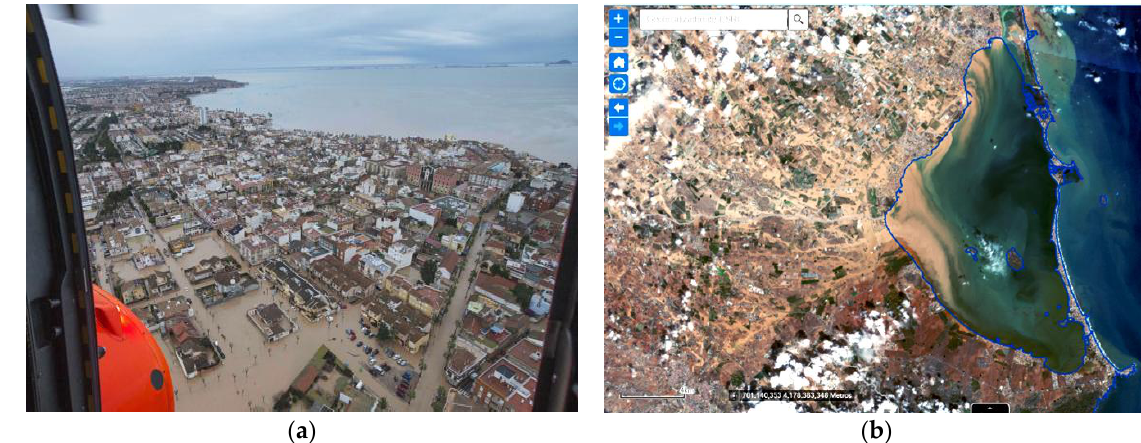
Figure 5 . ( a ) Flooding of the coastal town of Los Alcazares after the DANA ( depresión aislada en niveles altos ) in 2016 ( b ) Sentinel 2 satellite image of the effects of the 2019 DANA in the Mar Menor. Source: Emergency service of the Region of Murcia.